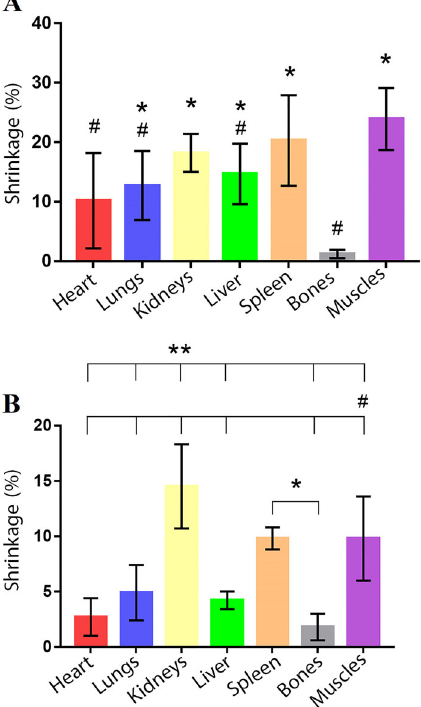
Figure 6. Mean (SD) percent shrinkage of the anatomical segments by silicone tested: S10 ( A ) and P1 ( B ). *P o 0.05 vs